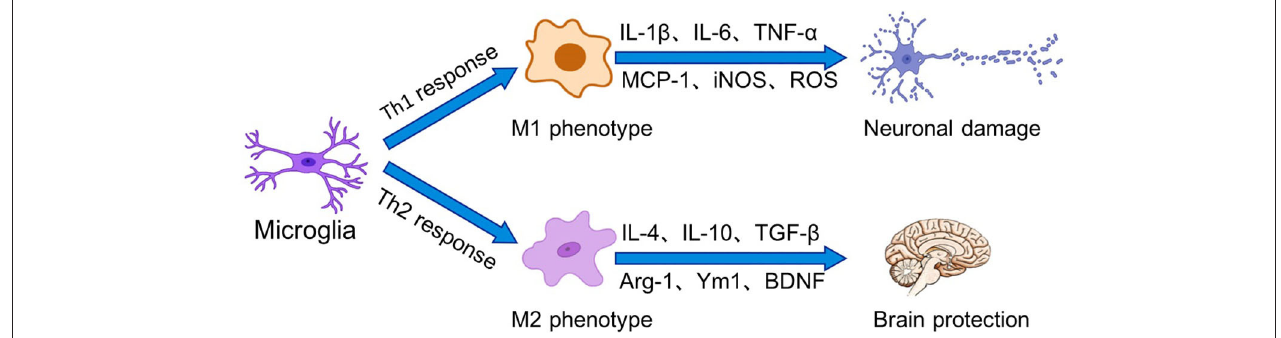
FIGURE 1 | Microglia perform surveillance functions of the extracellular environment of the brain in the resting state. In the presence of stressors, microglia can be activated into two states, which have been traditionally divided into M1 (classical activation) and M2 (alternative activation). Binding of receptors on microglia to Th1 cytokines drives microglia polarization to the M1 phenotype, leading to increased inflammation and oxidative stress as well as BBB dysfunction. In contrast, Th2 cytokines prompt microglia to polarize to the M2 phenotype. M2 phenotype microglia promote tissue repair and regeneration through the production of anti-inflammatory cytokines and neurotrophic factors for to exert neuroprotective